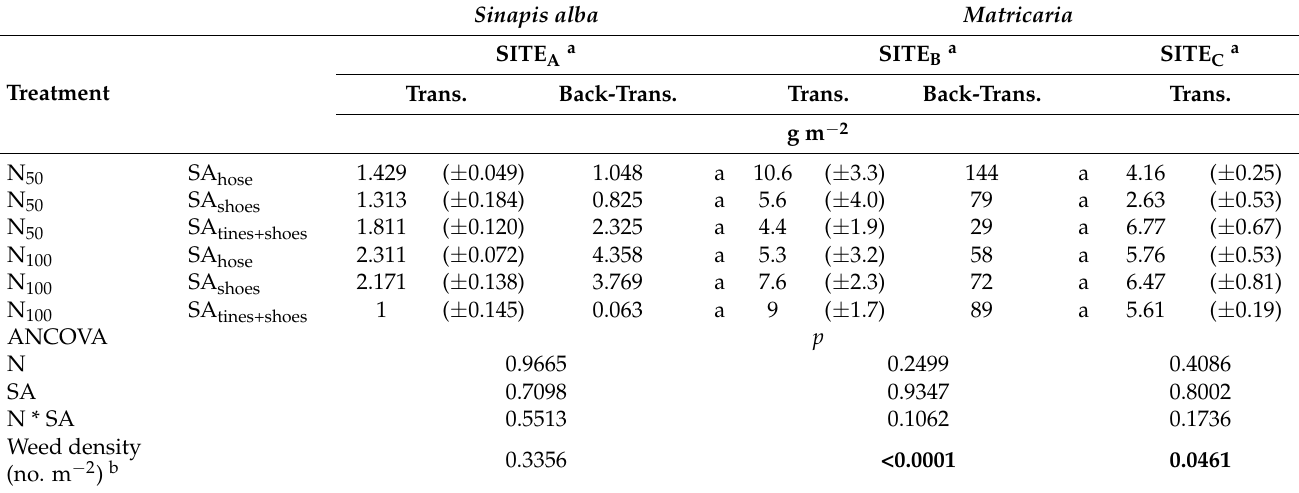
Table 4. The effect of nitrogen rate (N 100 and N 50 ) and slurry application method (SA hose , SA shoes , and SA tines+shoes ) on intra-row taprooted Sinapis alba (SITE A ) and Matricaria biomass (SITE B and SITE C ). Data from each site were analyzed separately. A connecting letters report displays differences among treatments, whereby means not sharing a similar letter are significantly different ( p <